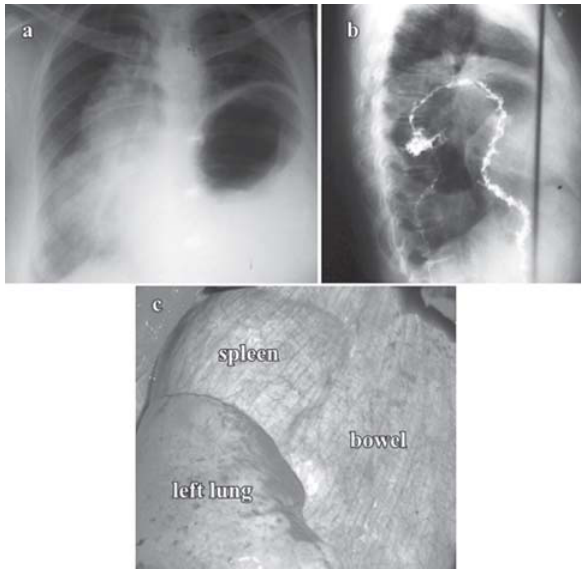
Fig. 1 – A: The preoperative chest X-ray showing a very high position of the left dome of the diaphragm, marked dislocation of the heart into the right hemithorax and displacement of the stomach and an intestinal loop into the left thoracic cavity. B: The preoperative barium meal examination revealing multiple bowel loops in the left hemithorax. C: Intraoperative photograph showing the thoracic cavity filled with abdominal organs up to the aortic arch that were covered with a very thin and completely transparent colourless membrane which represented the diaphragm